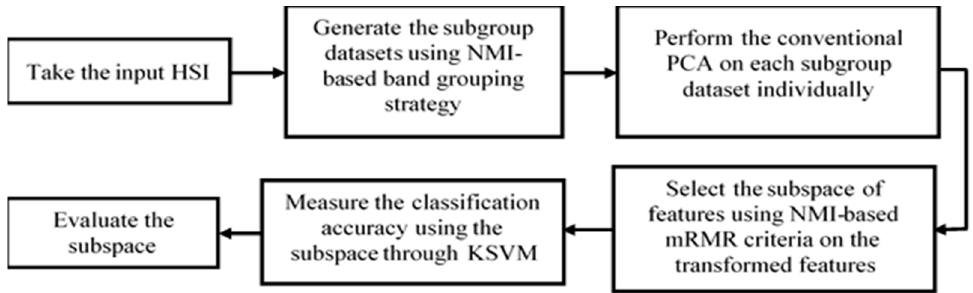
Figure 1. The workflow of the proposed BgPCA-NMI.